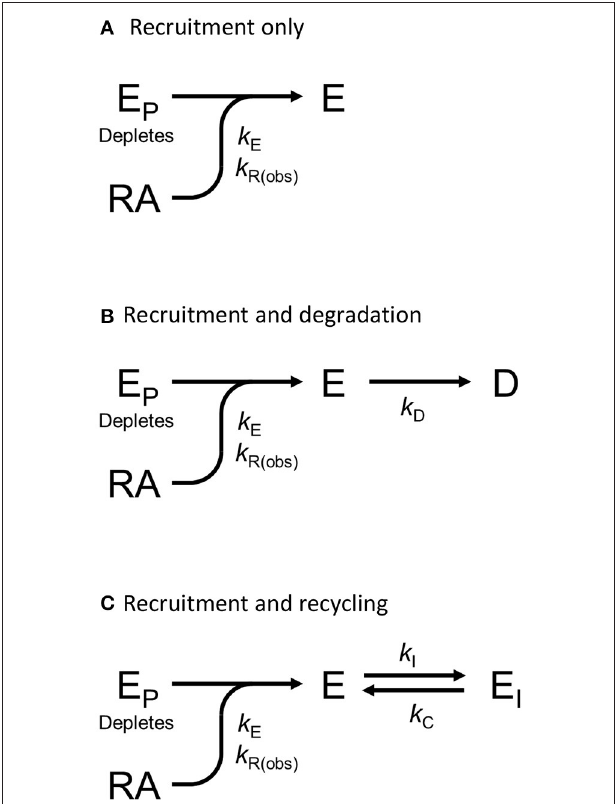
FIGURE 9 | Mechanism schemes used to formulate the arrestin recruitment equations. Simplified pharmacological models of arrestin recruitment and subsequent regulation steps were formulated for analyzing the arrestin waveform data, to evaluate the mechanism in operation and to enable estimation of the macroscopic rates of the processes. These models employ a previously-published conceptual framework ( Hoare et al., 2018, 2020b). (A) Arrestin recruitment model. E P is free arrestin, E is arrestin bound to the receptor, RA is the receptor bound by the agonist, and k E the microscopic rate constant for arrestin binding to the receptor. k R(obs) is the observed rate of arrestin recruitment (equal to k E multiplied by the agonist-occupied receptor concentration). (B) Arrestin recruitment and degradation pathway model. Following recruitment, the complex is degraded, represented by formation of the degraded product D, defined by the rate constant k D . (C) Arrestin recruitment and recycling pathway model. Here the complex breaks